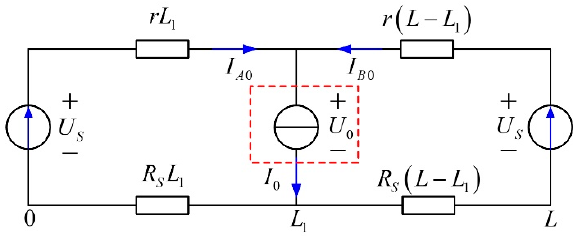
Figure 4. Powered equivalent model.